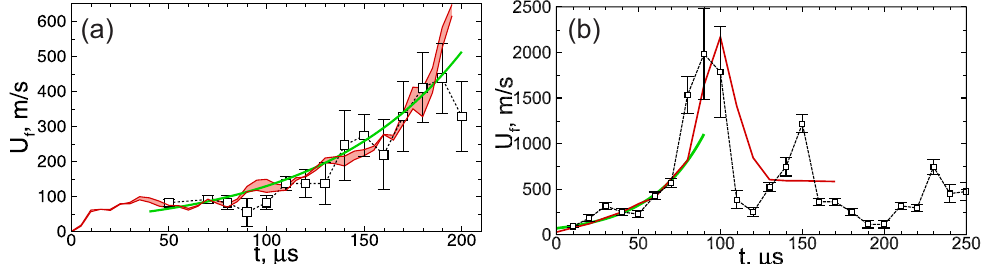
Figure 3. History of the flame speed in the emulsions ( a ) containing 0.5 vol.% of heptane and foamed with 0.5H 2 + O 2 mixture and ( b ) containing 0.5 vol.% of heptane and foamed with 2H 2 + O 2 mixture. Red line—calculations (red region between red lines in frame ( a )—divergence obtained from the series of calculations), signs connected with dotted line—experiment from [19], green line—exponential